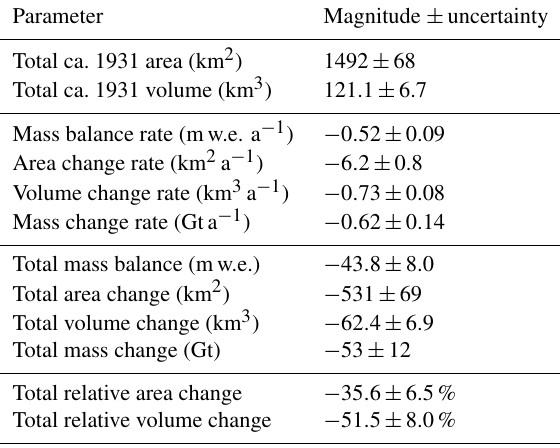
Table 2. Swiss-wide change rates and total changes in specific mass balance ( B ), thickness, area, volume, and mass from 1931–2016. See Eqs. (2)–(5) for how these are calculated. The uncertainties are the 95% confidence